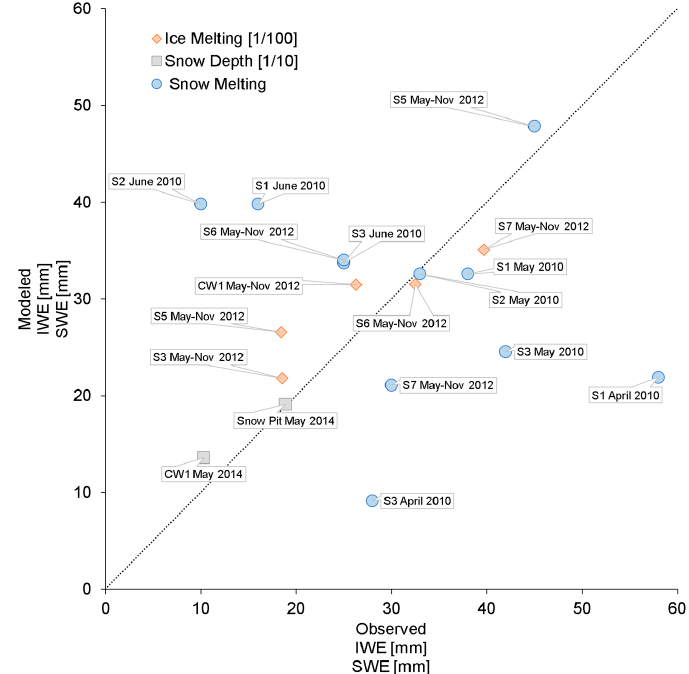
Figure 2. West Khangri Nup. Ice and snow ablation model. Goodness of fit of the modeled values at the measuring stakes. IWE is ice water equivalent, or ice melt M i . SWE is snow water equivalent, or snow melt M i . Snow depth is used in some cases for validation. For each stake, the measurement period is reported. Different periods for each stake indicate readings at different dates. Snow depth values to be multiplied by 10 (1 = 10 mm). Ice melt data to be multiplied by 100 (1 = 100 mm).